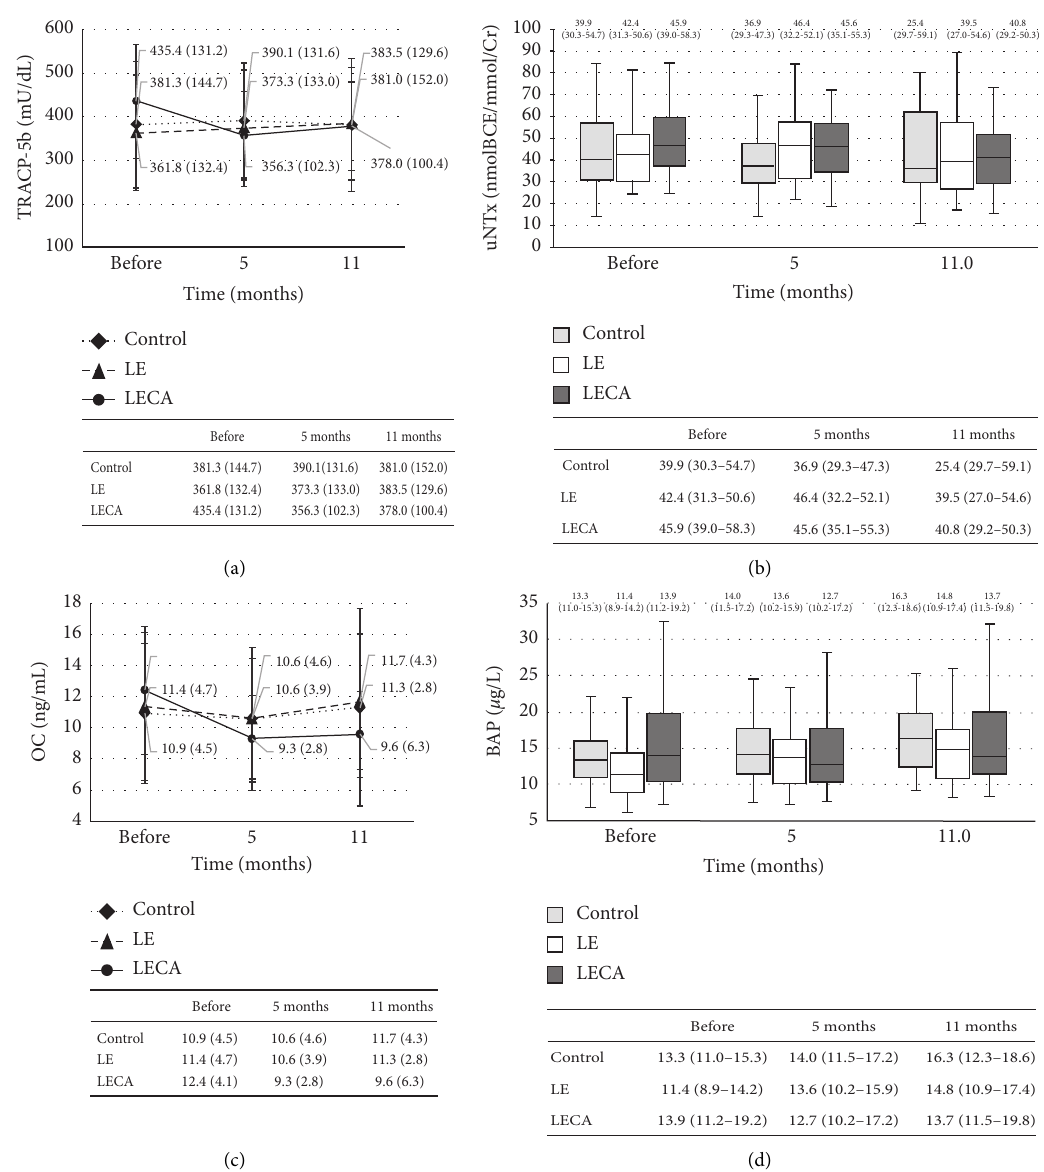
Figure 3: Relationship between ingested product and bone resorption markers. (a) Changes in TRACP-5b concentration. (b) Changes in uNTx for each group (chronological). (c) Changes in OC concentration. (d) Changes in BAP concentration for each group (chronological). (a, c) Values are shown as the mean (SD) with error bars. Dotted line is the control group, dashed line is the LE group, and solid line is the LECA group. Two-way factorial analysis of variance was performed with type of ingested product and intervention period as factors. p values for ingested product (drink), intervention period (time), and interaction are shown ( † ). (a) Drink: p � 0.840; time: p � 0.967; interaction: p < 0.001 † . (c) Drink: p � 0.788; time: p � 0.254; interaction: p � 0.006 † . (b, d) Values are shown as the median (interquartile range) (25%– 75%) with error bars. Light grey box is the control group, blank box is the LE group, and dark grey box is the LECA group. Friedman’s test with type of ingested product and intervention period as factors was used. p values for each group are shown ( ‡ ). (b) Control: p � 0.401 ‡ ; LE: p � 0.248 ‡ ; LECA: p � 0.131 ‡ . (d) Control: p < 0.001 ‡ ; LE: p < 0.001 ‡ ; LECA: p < 0.001 ‡ . TRACP-5b: tartrate-resistant acid phosphatase type 5b; uNTx: urinary type I collagen cross-linked N-telopeptide; OC: osteocalcin; BAP: bone alkaline